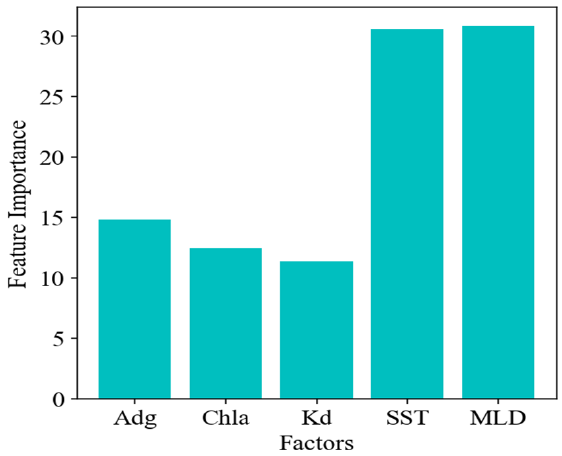
Figure 10. The proportion of each remote sensing variable in the results of the inversion with the CatBoost model.